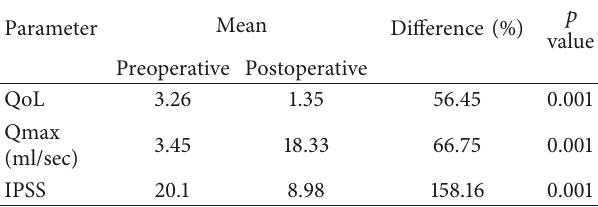
Table 1: Presentation of results.